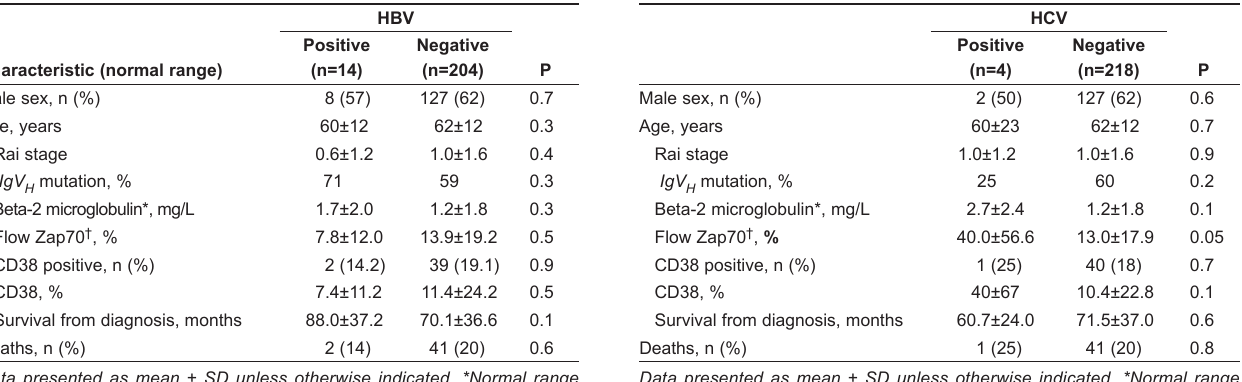
Table 4 Comparisons of hepatitis C virus (HCV)-positive and HCV- negative chronic lymphocytic leukemia